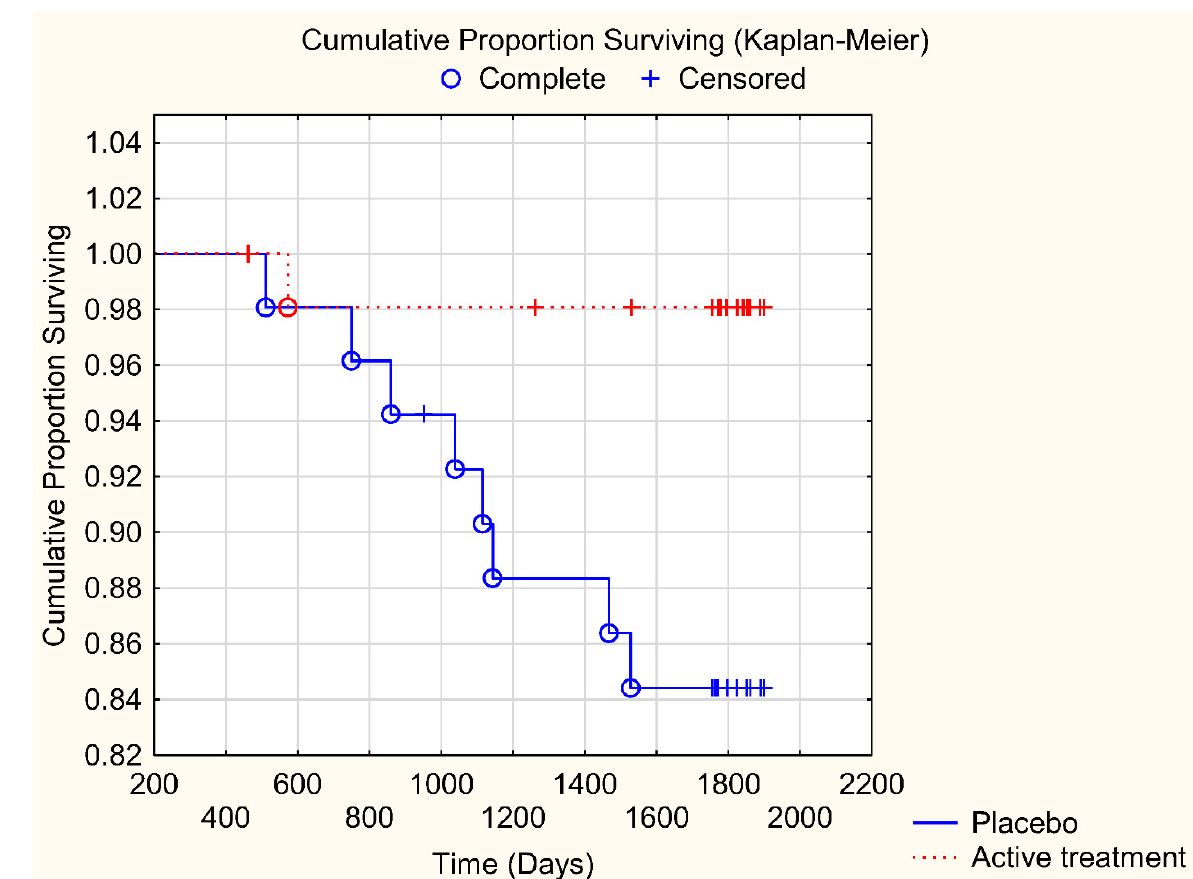
Figure 2. Kaplan–Meier graph illustrating cardiovascular mortality in participants with a D-dimer level above median (0.21 mg/L) and given selenium and coenzyme Q 10 treatment versus those on placebo during a follow-up period of 4.9 years. Note: Censored participants were those still living at the end of the study period, or who had died for reasons other than cardiovascular disease. Completed participants were those who had died due to cardiovascular disease.